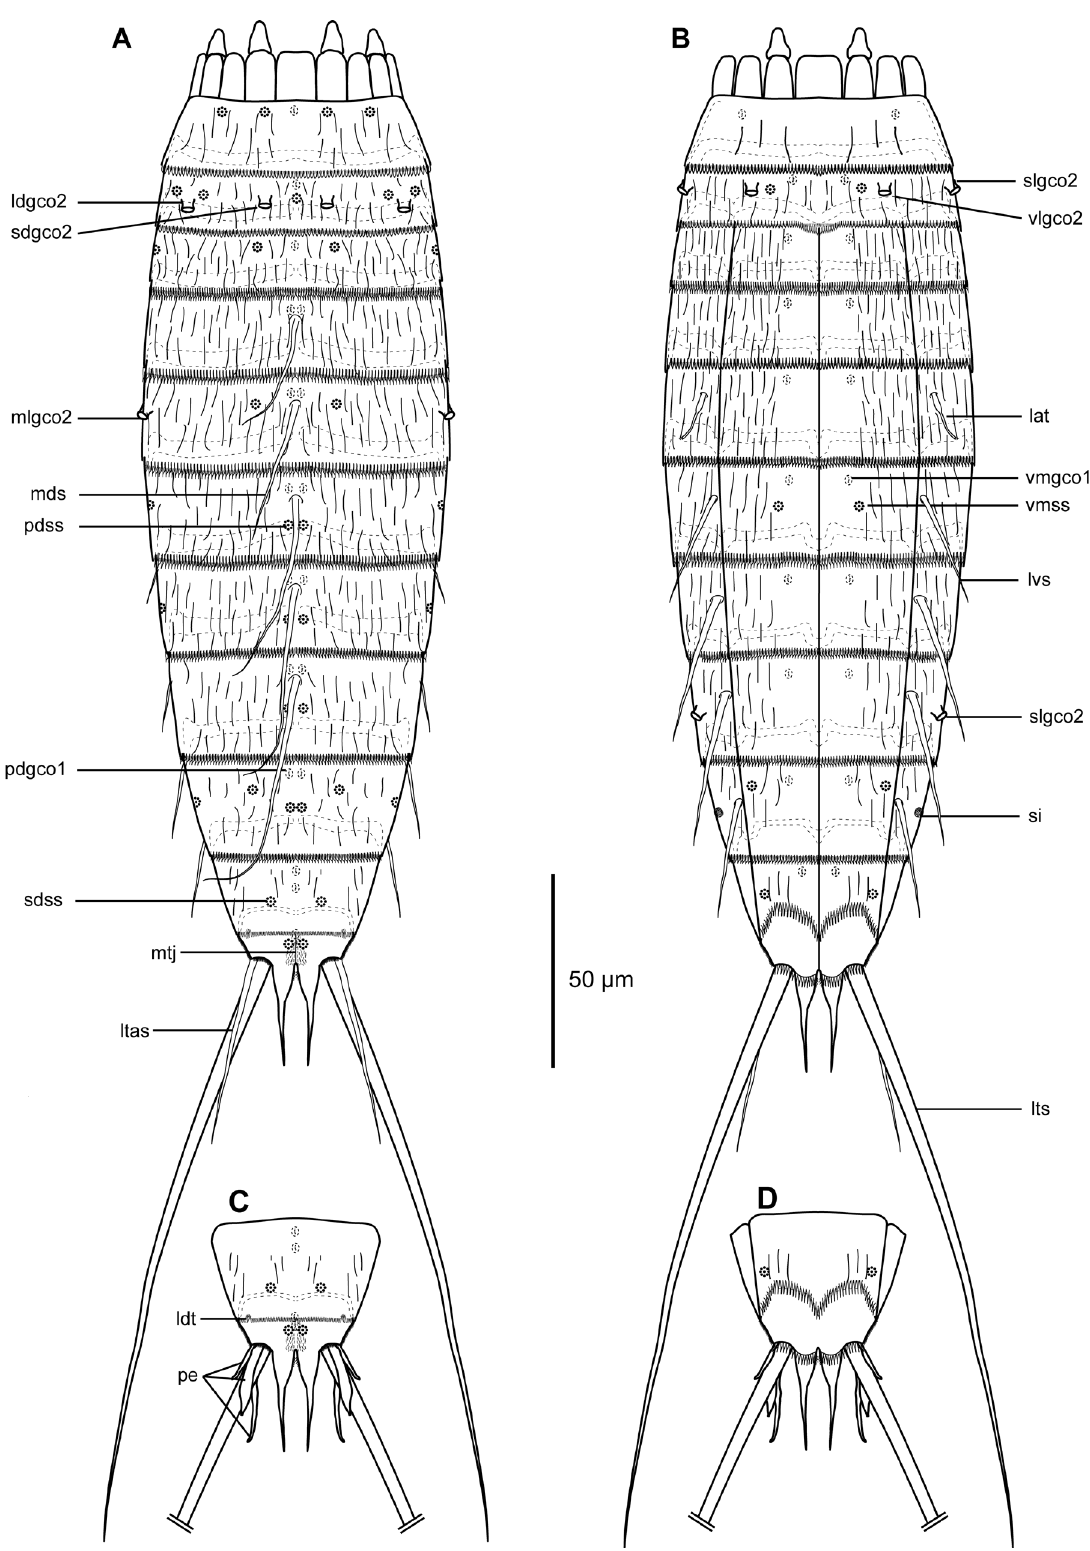
Fig. 29. Line art illustrations of Echinoderes galadrielae sp. nov. A . ♀, dorsal view. B . ♀, ventral view. C . ♂, segments 10–11, dorsal view. D . ♂, segments 10–11, ventral view. Abbreviations: see Material and